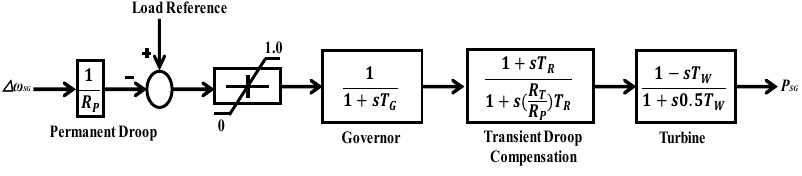
Figure 4. Governor model of hydro turbine.